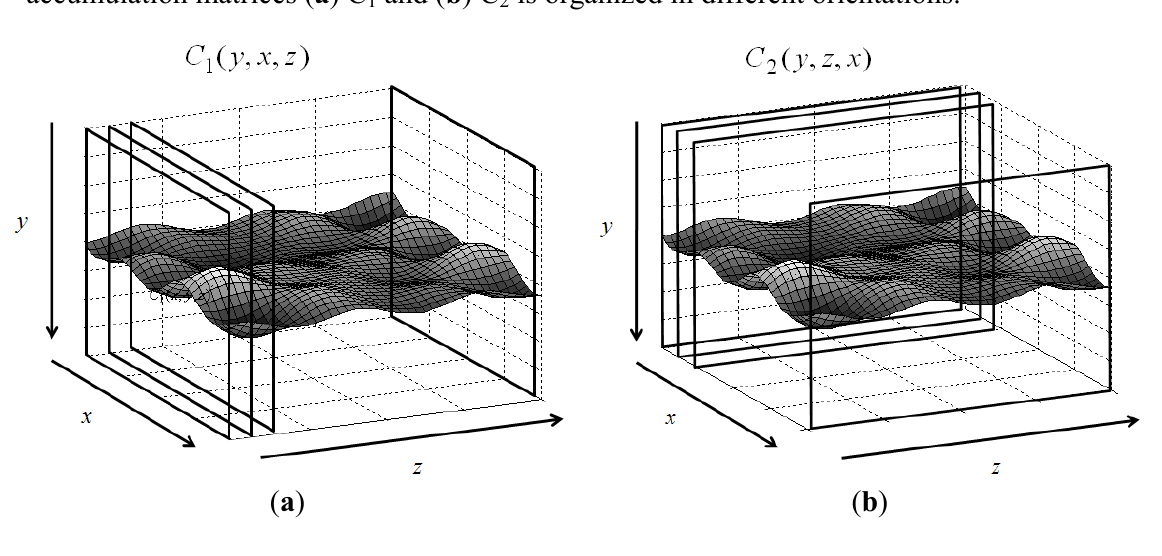
and ( b ) C is organized in different 1 2